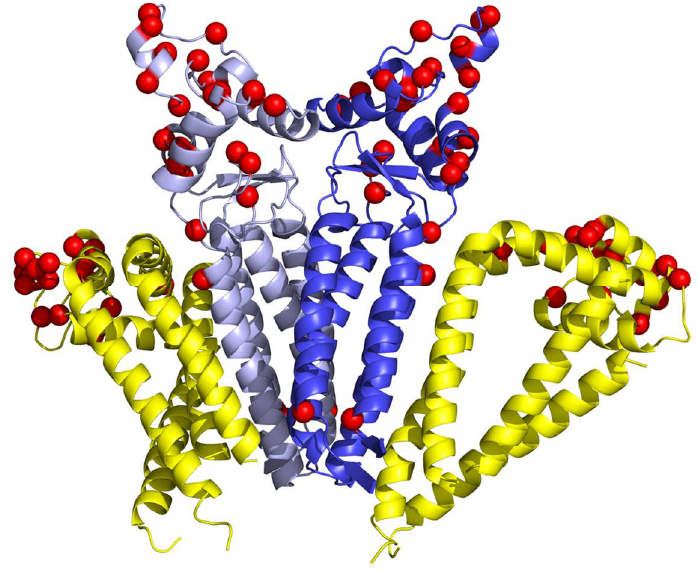
Figure 11. The position of non-identical amino acids between human and mouse CD81 and CD9 projected onto the model of CD9/CD81 complex (Figure 9C). The differences in amino acid sequence are depicted as red spheres. The CD81 moiety (yellow) contains 17 differences in the extracellular domain, while the CD9 (shades of blue) differs in 25 amino acids located also at the CD9/CD81 interface. These differences could be responsible for species specific interaction between CD9 and CD81 as well as recognition by other proteins.